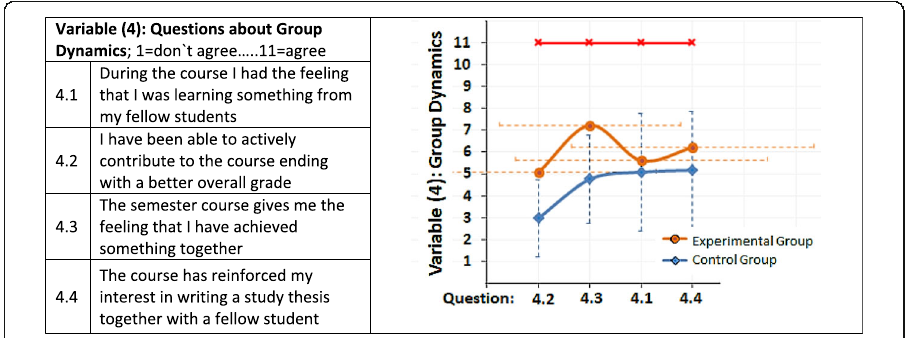
Fig. 6 Post-Test results for Variable (4). Significant (p ≤ .05) for questions 4.2 and 4.3, horizontal line shows theoretical maximum, dotted lines indicate scattering of values